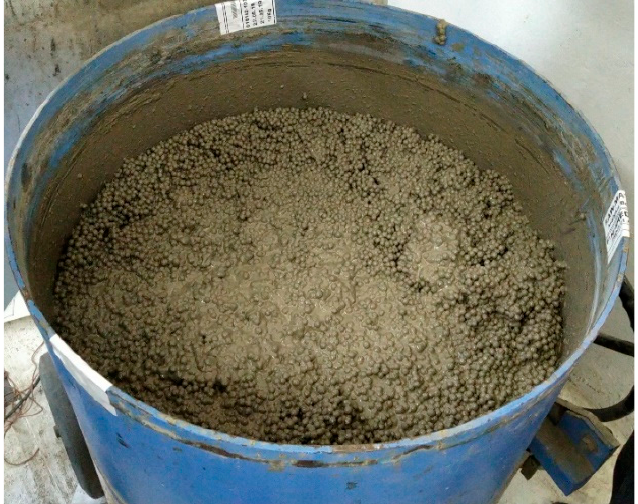
Figure 10. Mixing of CFA-based LW mix.